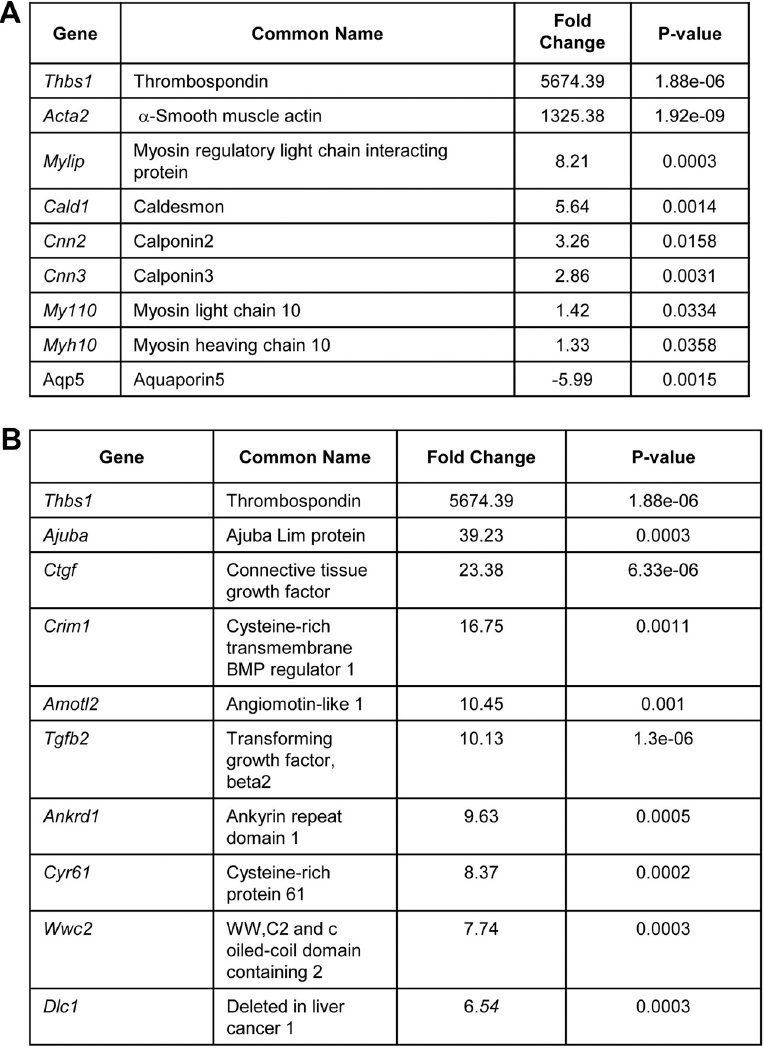
Fig 4. mSG-PAC1 spheroids cultured in Pro-M medium up regulate myoepithelial markers & YAP/TAZ target genes. (A) List of myoepithelial genes upregulated in mSG-PAC1 spheroids Pro-M medium cultured in for six days. Data is presented as the fold increase compared to spheroids cultured in Pro-A medium. (B) List of YAP/TAZ target genes upregulated in by spheroids cultured Pro-M medium. Data is presented as the fold increase compared to spheroids cultured in Pro-A